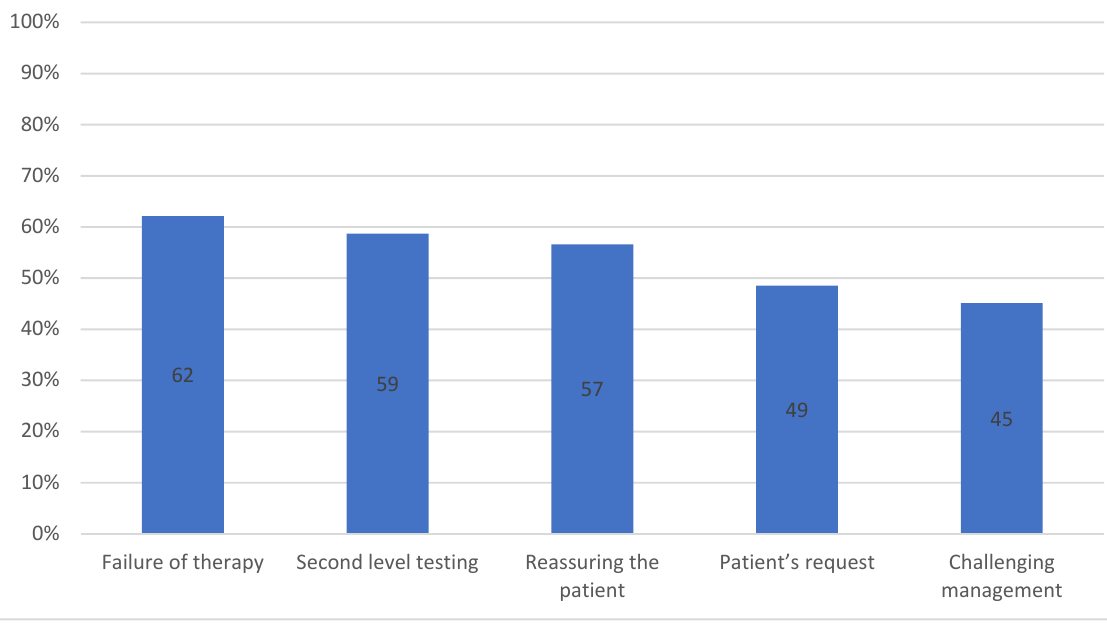
Figure 2. Gastroenterological consultation: frequency of different reasons.